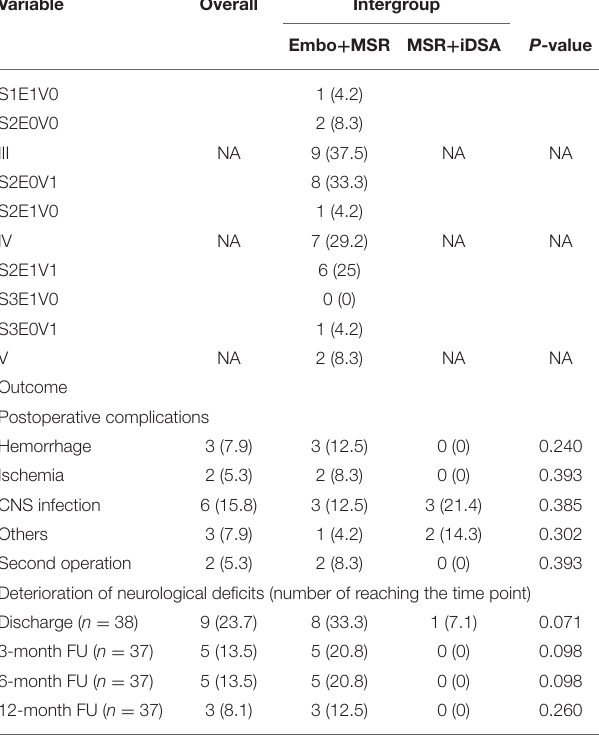
TABLE 1 | Characteristics in patients with SMG IV and V bAVMs *